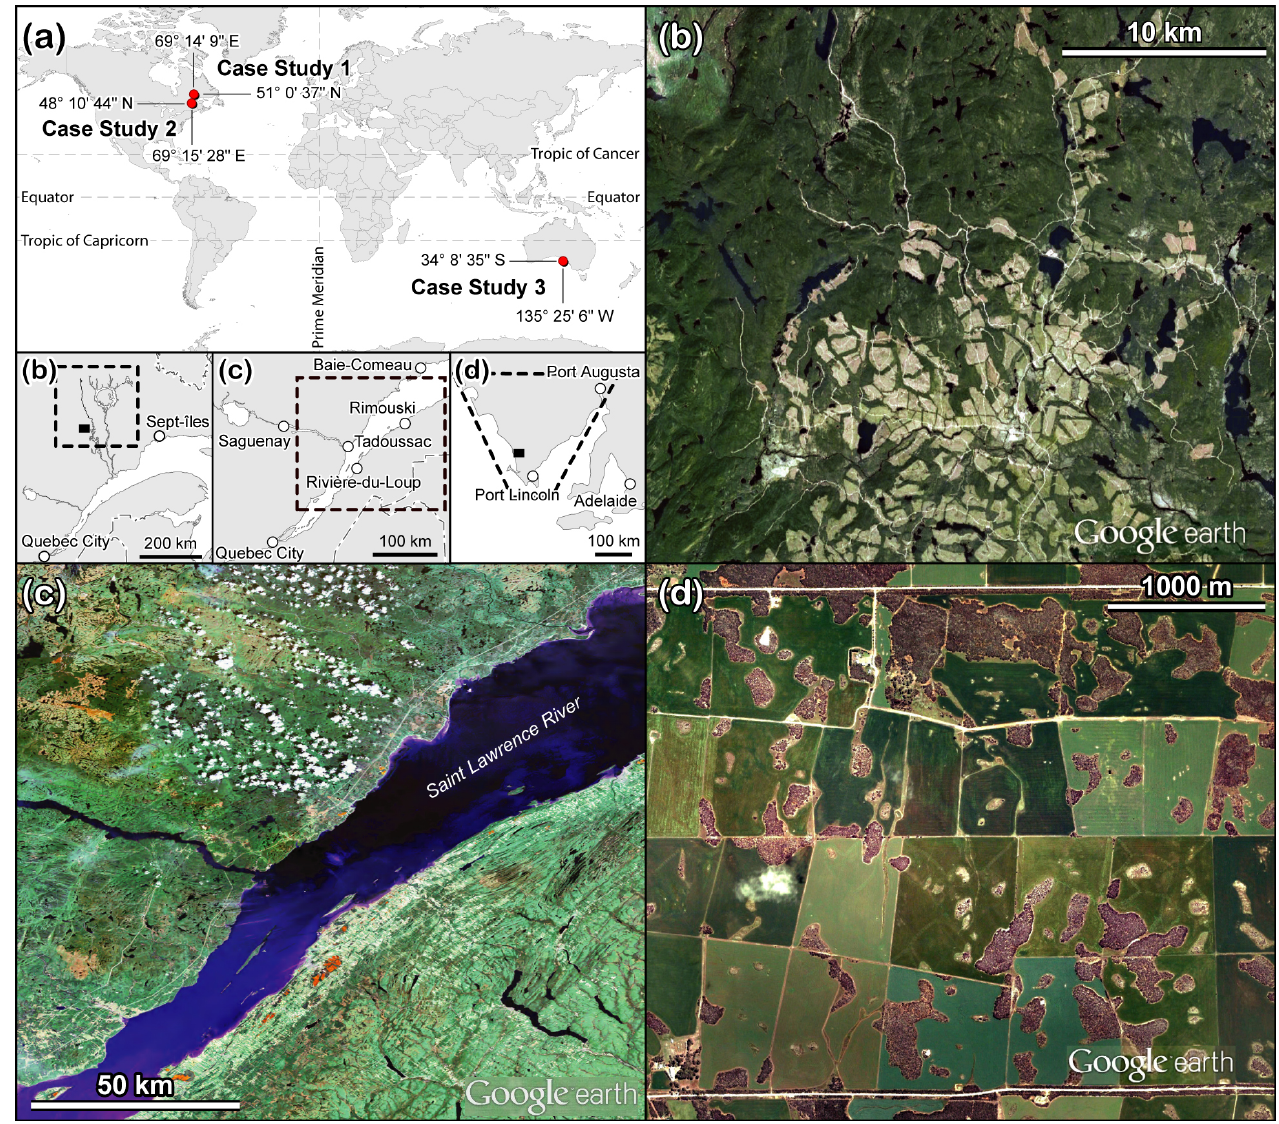
Fig. 3 . Locations and representative landscapes of the three study areas described in the text. (a) Locations on the world map. Insets show the extent of each study area (dashed line) and the locations of images b and c (dark rectangles). (b) Representative area of the landscape of case study 1, showing the spatial configuration of cutblocks and residual forest. (c) View of the estuary and surrounding landscape of case study 2. (d) Representative area of the landscape of case study 3, showing agricultural fields and remnant vegetation